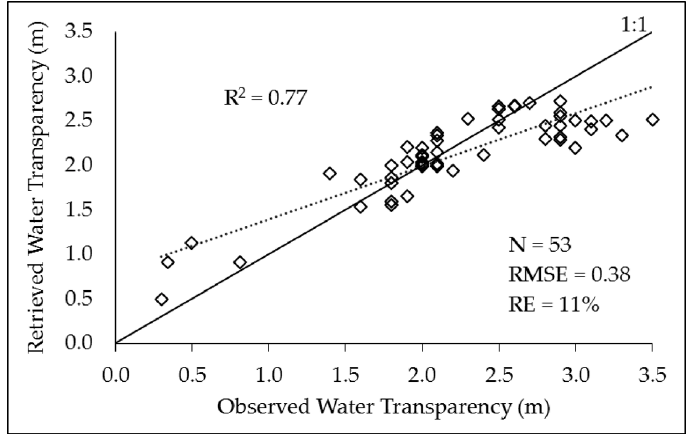
Figure 12. Observed and retrieved (satellite-derived) water transparency in the south basin of Lake Biwa (1 October 2013). N; number of validation points; RMSE: root-mean-square error; RE: relative error.